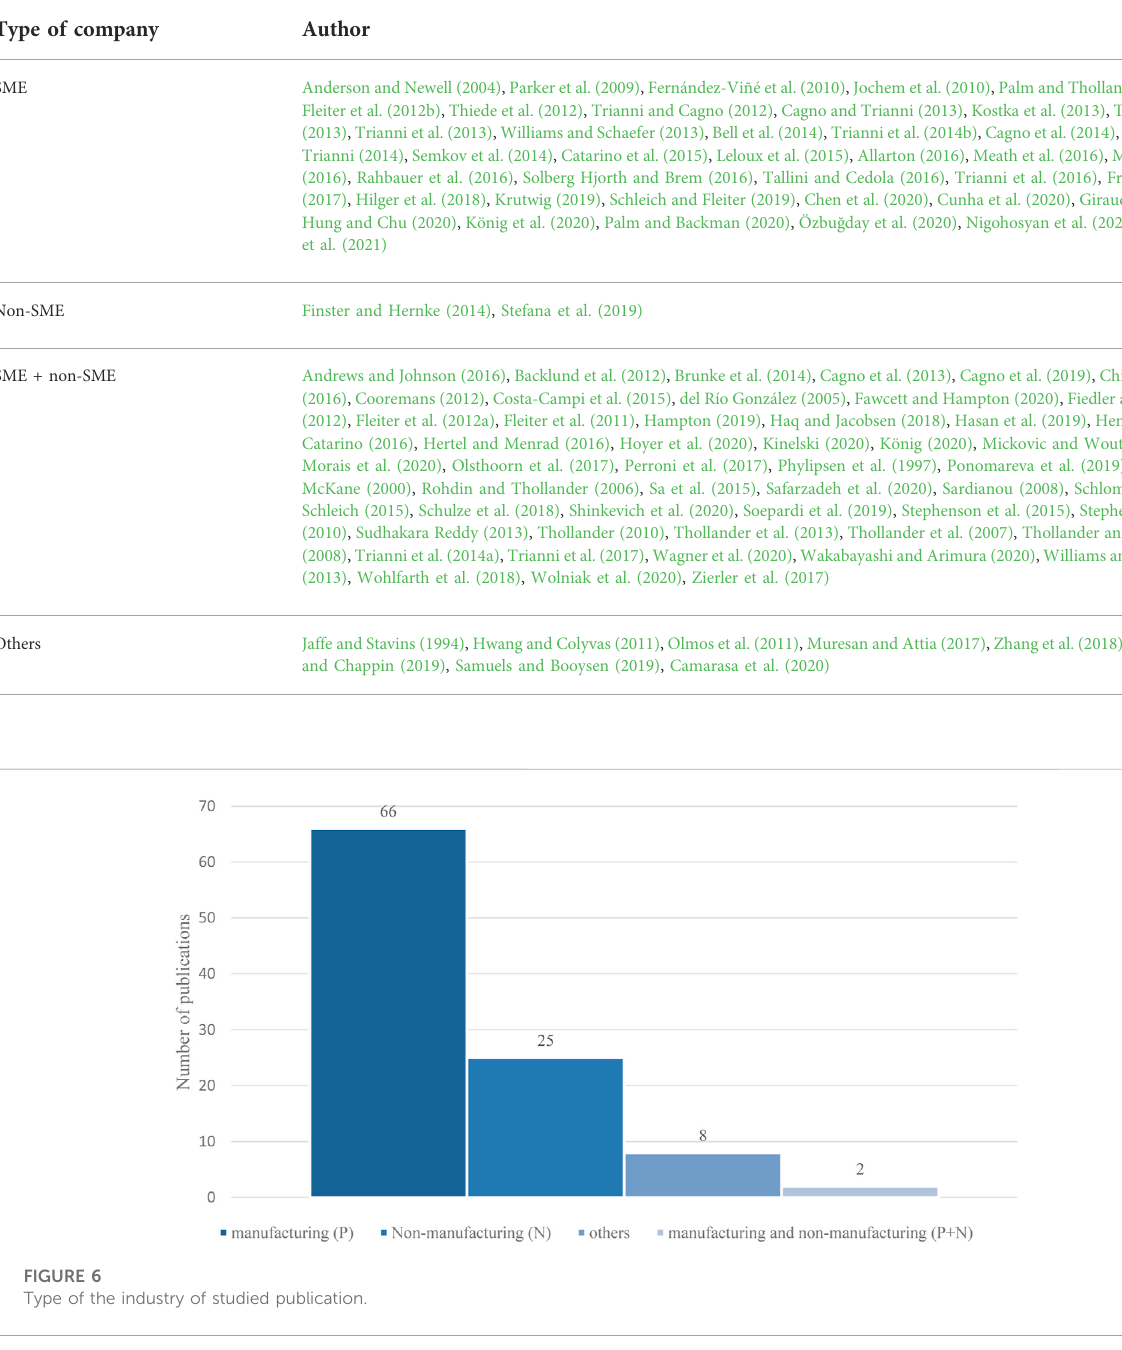
TABLE 3 Classi fi cation of articles by type of company.